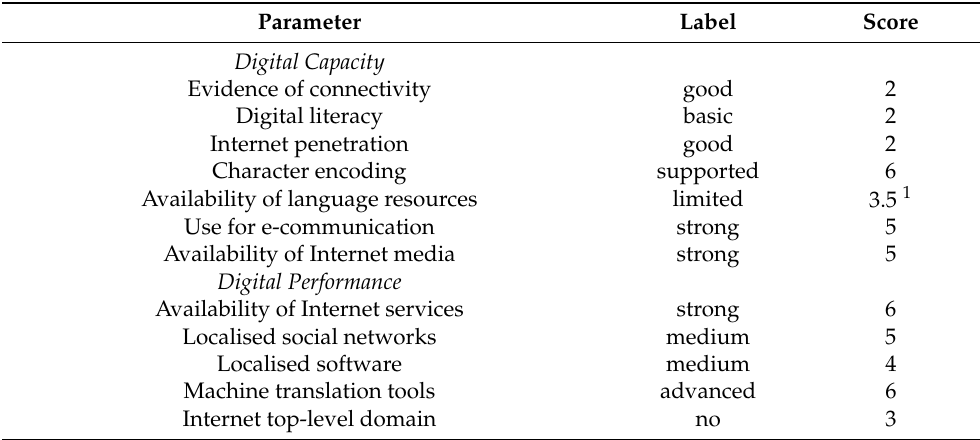
Table 1. The digital language vitality assessment of Esperanto (following Ceberio et al. 2018). Parameter Label